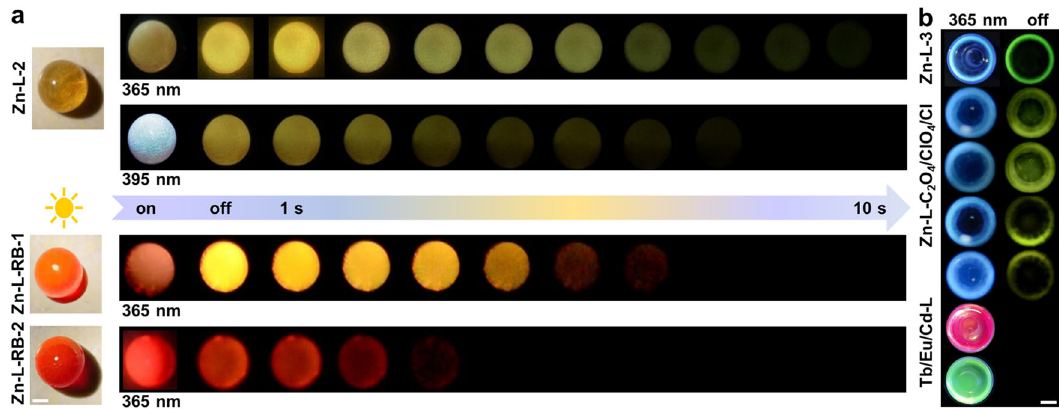
Fig. 3 | Representative images of ultralong RTP observed in the glasses. a Images of spherical Zn – L-2 and Zn-L-RB-1/2 SGs taken before and after the exci- tation turned off across a time scale of 0 to 10s. b Images of thin Zn – L-3, Zn-L-Cl/